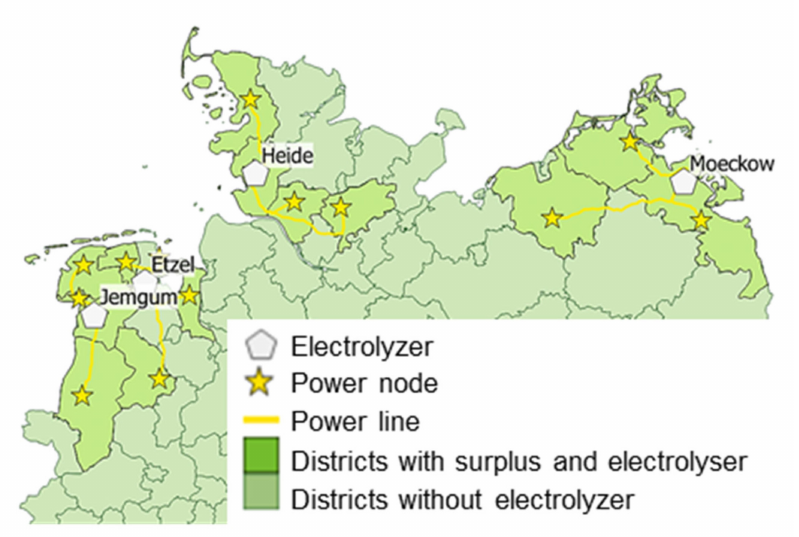
Figure 2. Germany’s production sources distribution